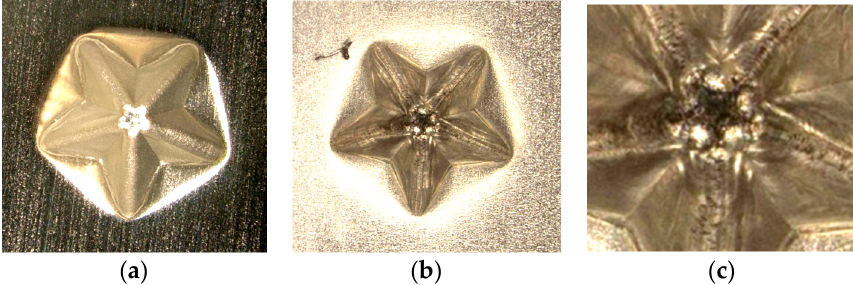
Figure 10. Top and bottom views of a star pyramid formed without ultrasonic vibration: ( a ) top view; ( b ) bottom view; ( c ) magnified center part of bottom view.